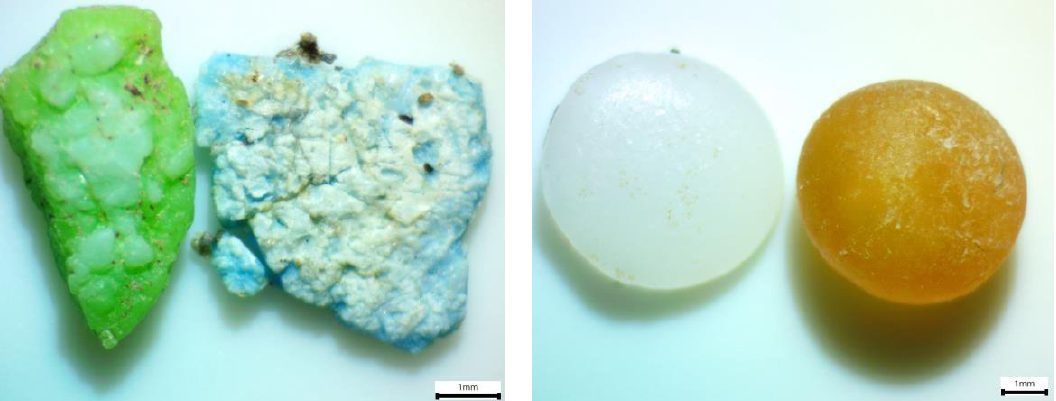
Figure 5. Loupe view of irregularities and roughness presented by MPs found on the beaches of Tenerife. MPs picked from Playa Grande on 21 April 2021. Left image shows high irregularities and roughness of the fragments. Right image shows low irregularities and roughness of the pellets (weathering and not weathering).